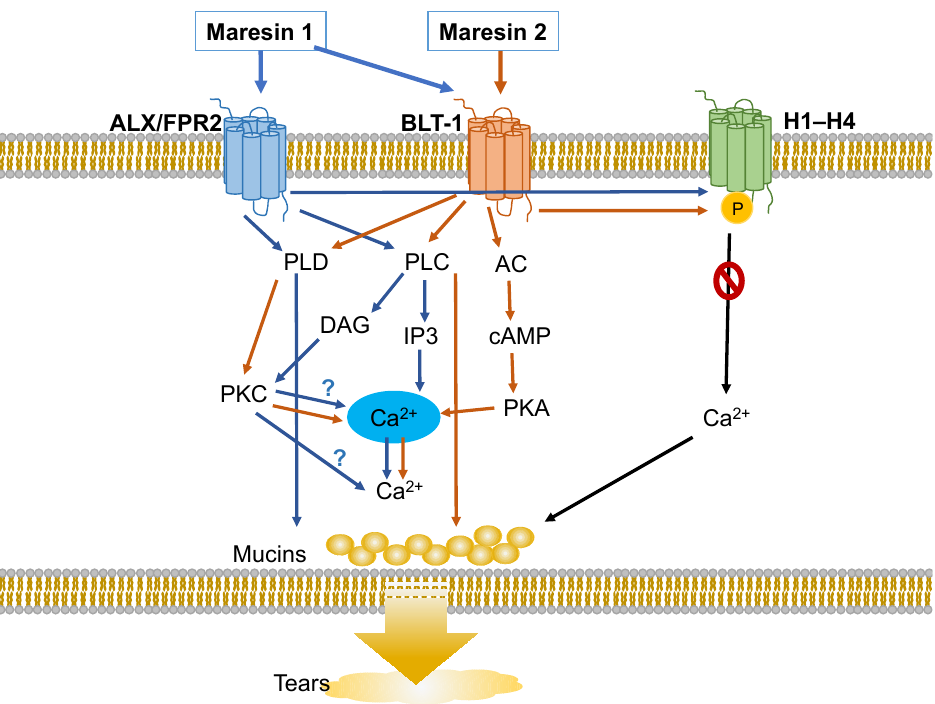
Figure 11. Schematic diagram of signaling pathways activated by Maresin 2 (MaR2) (orange arrows) compared to the pathways activated by Maresin 1 (MaR1) (blue arrows). MaR2 activates the BLT1 receptor activating PLD, AC, PLA 2, and PLC. PLD and AC activate downstream molecules that increase [Ca 2+ ] i causing glycoprotein secretion. PLA 2 and the PLC pathway stimulates glycoprotein secretion by another unknown mechanism than increasing [Ca 2+ ] i .